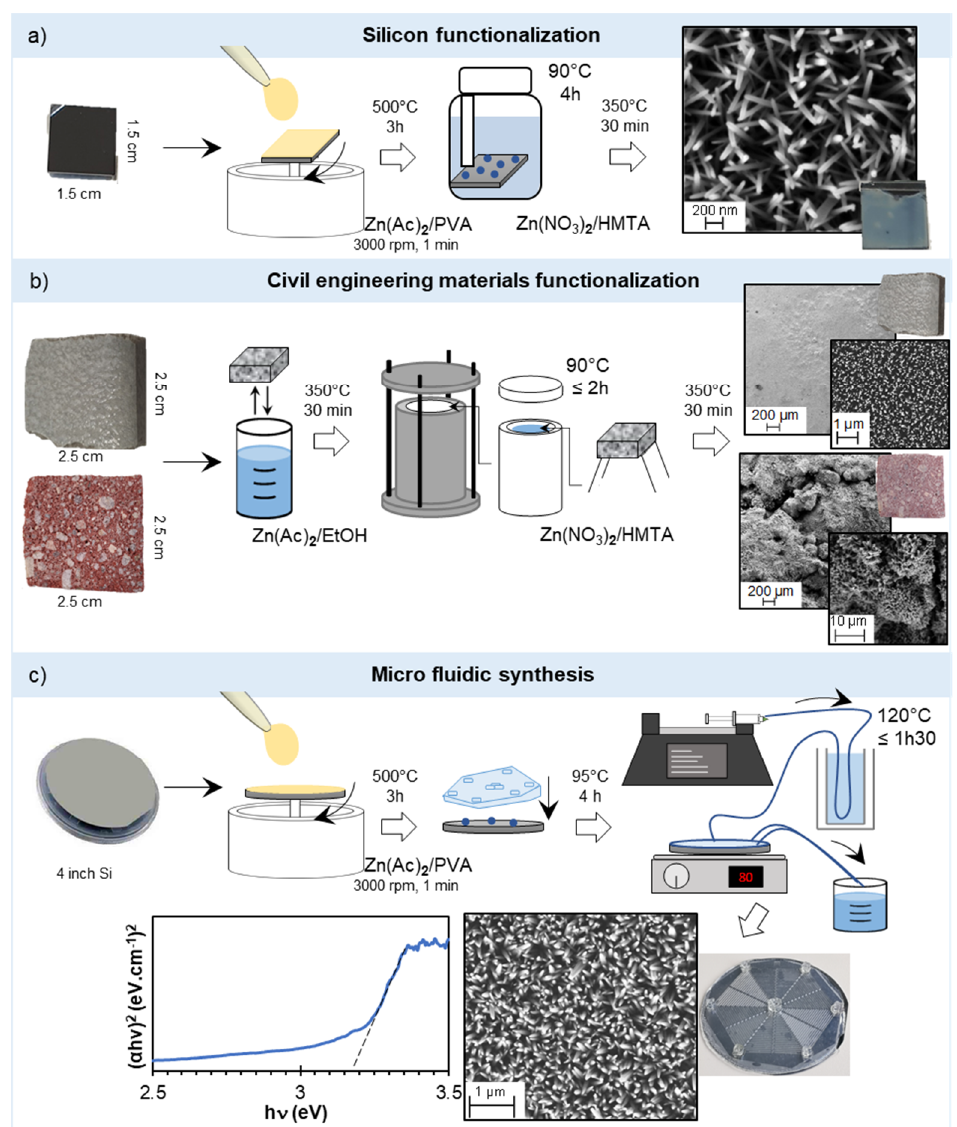
Figure 2. Experimental set-up schema of different developed ZnO NSs synthesis from silicon functionalization ( a ) and civil engineering materials functionalization ( b ) to micro fluidic reactor production ( c ) and obtained SEM images.